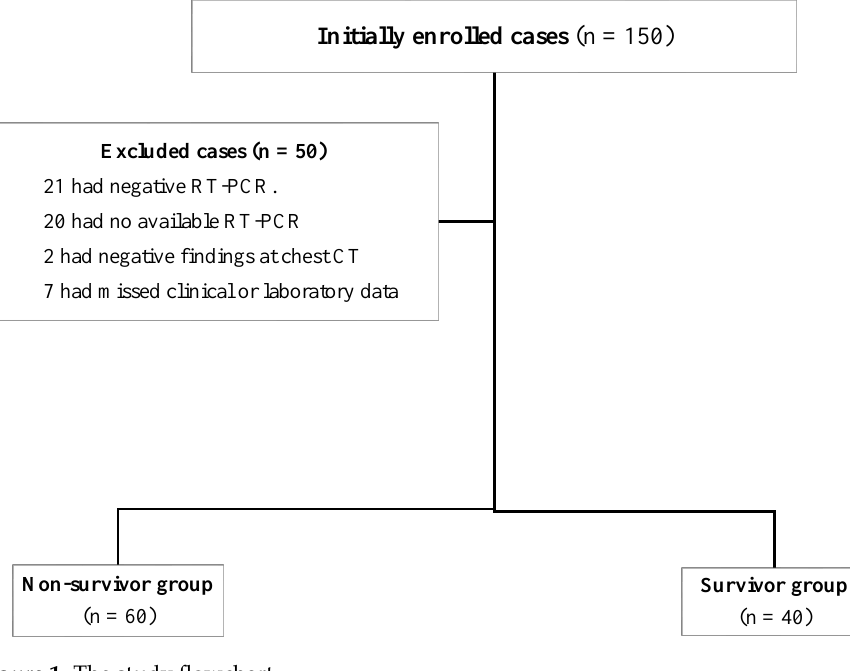
Figure 1. The study flowchart.